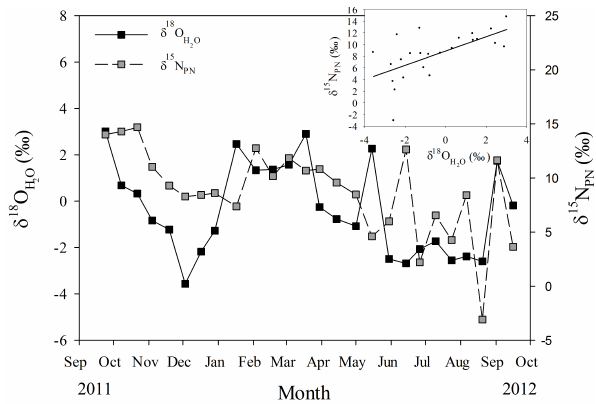
Fig. 7. A strong correlation was observed ( p = 0.0258, n = 26) between δ 18 O H and δ 15 N PN at S20 over a 12-month sampling 2 O period, with more elevated δ 15 N PN exported under drier conditions. and δ 15 N PN with a one-month (Inset) Linear regression of δ 18 O H 2 O forward shift of δ 18 O H ( y = 8.8888 + 1.2241 x ; r 2 = 0.3878). The 2 O relationship weakens without the forward shift of δ 18 O H ( y = 2 O − 2 . 2256 + 0.2098 x ; r 2 = 0.1905).